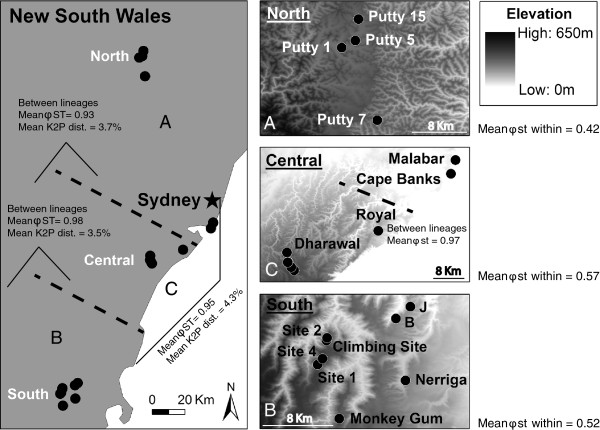
Average distances moved by juvenile, male and female geckos  Oedura lesueurii at sites in the Putty region (Yengo and Wollemi National Parks), Dharawal State Conservation area and Morton National Park. Mean recapture intervals differed among samples, but averaged 203 days. The graph shows mean values and associated standard errors.